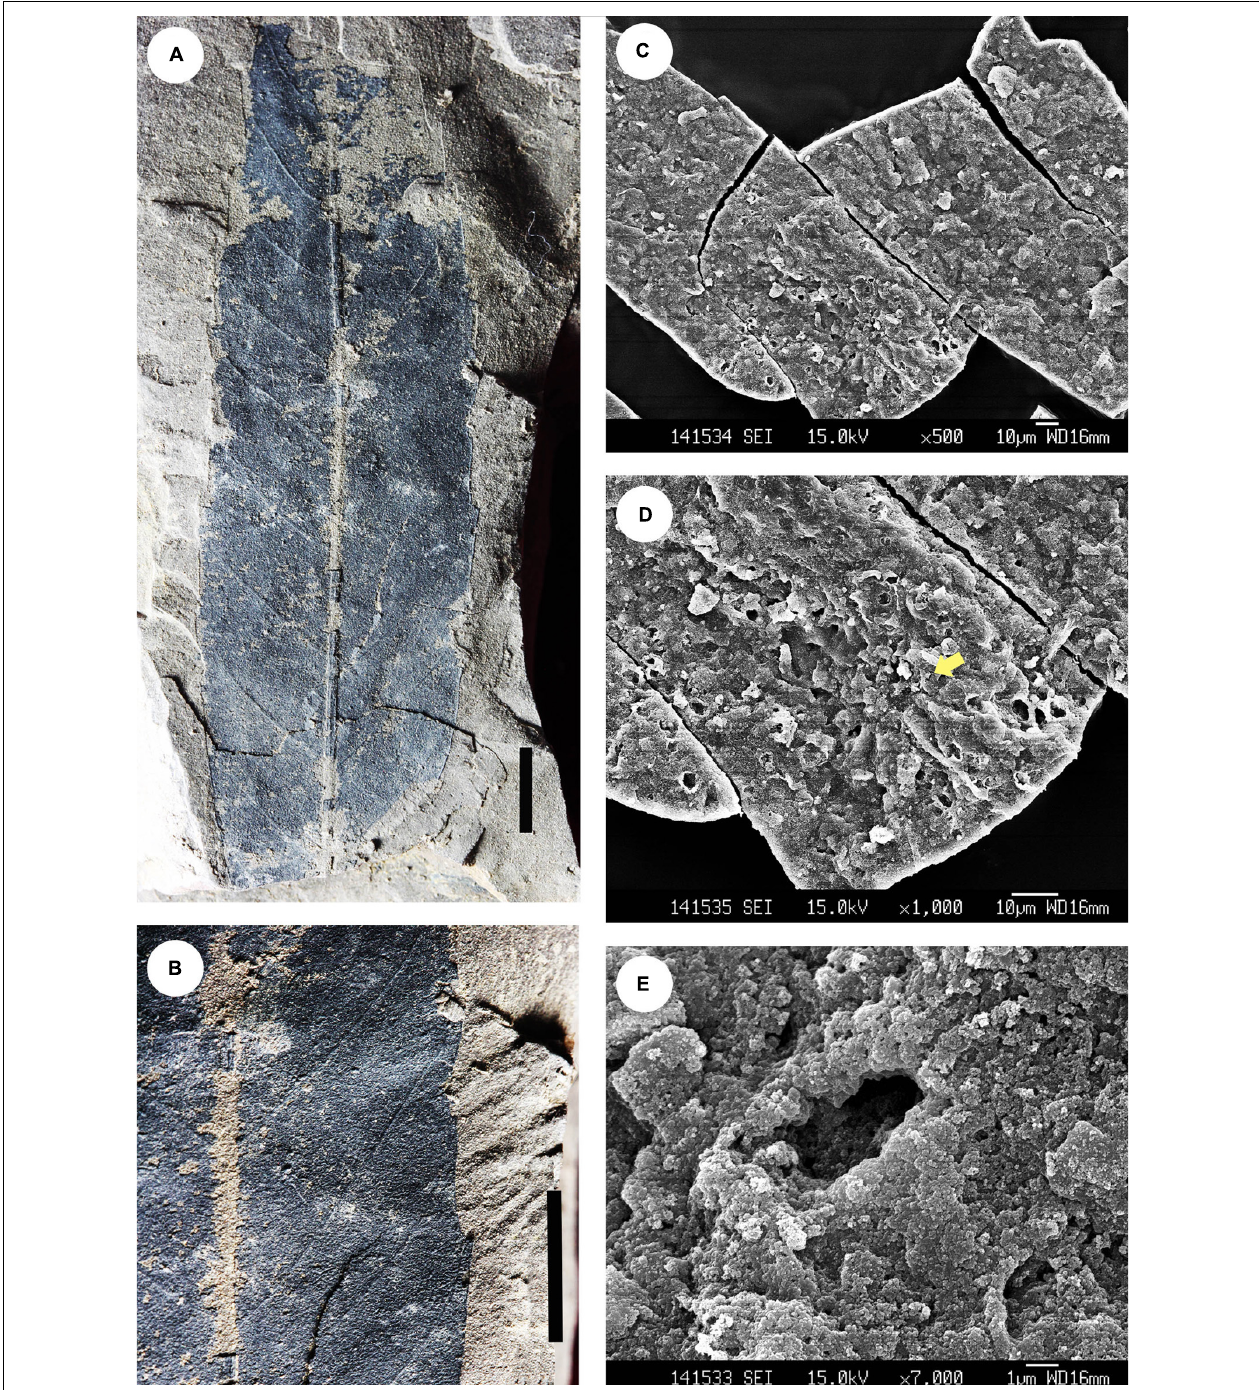
FIGURE 7 | Morphology of Castaneophyllum cf. moorii (Lesq.) Jones et Dilcher. (A) Specimen No. CC-1136, showing leaf morphology; (B) enlargement of (A) , showing teeth, tertiary veins and quaternary veins; (C) stellate trichomes and rugose structures on the outer surface; (D) yellow arrow indicates stellate trichomes; (E) SEM image showing stomata. Scale bars: 10 mm (A) ; 5 mm (B) .